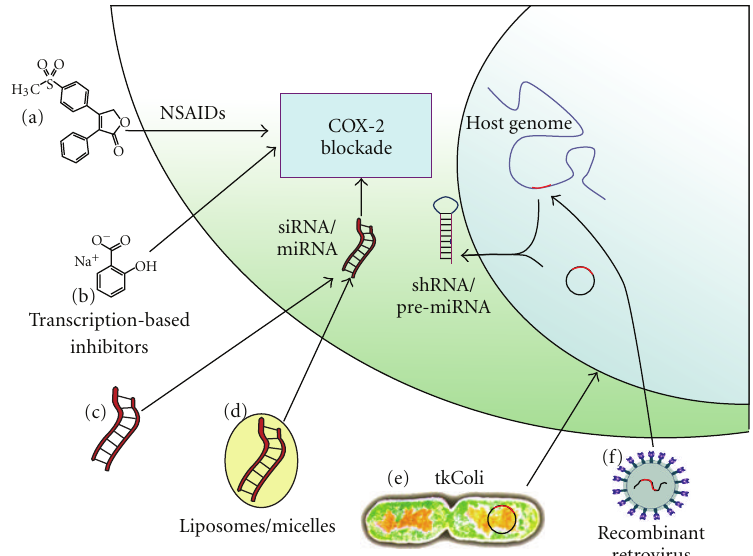
Figure 3: The di ff erent strategies for COX-2 blockade. (a) COX-2 selective NSAIDs (e.g., celecoxib, rofecoxib, etoricoxib) represent to date the only drugs marketed for COX-2 selective inhibition, even if rofecoxib has been withdrawn due to its toxicity; (b) inhibitors of transcriptional factors expression and/or activity (e.g., C/EBP β transactivator) may block COX-2 overexpression associated to inflammation or cancer; (c) anti-COX-2 siRNAs (siCOX-2) or miRNAs (e.g., miR-101) with structural modifications that improve their stability may block COX-2 expression after intravenous administration; (d) polymer- or lipid-based delivery systems protect siRNAs or miRNA from the extracellular environment and, modifying their shell, a more selective cellular targeting can be obtained; (e) nonpathogenic bacteria ( E. coli ) can be engineered in order to invade target cells and induce RNAi against COX-2 (transkingdom RNAi, tkRNAi) by releasing DNA plasmids that express siCOX-2 or miR-101 precursors; (f) anti-COX-2 shRNA (shCOX-2) or pre-miRNA expression cassettes can be transduced into target cells genome by the use of recombinant retroviruses, allowing a stable COX-2 silencing into mammalian